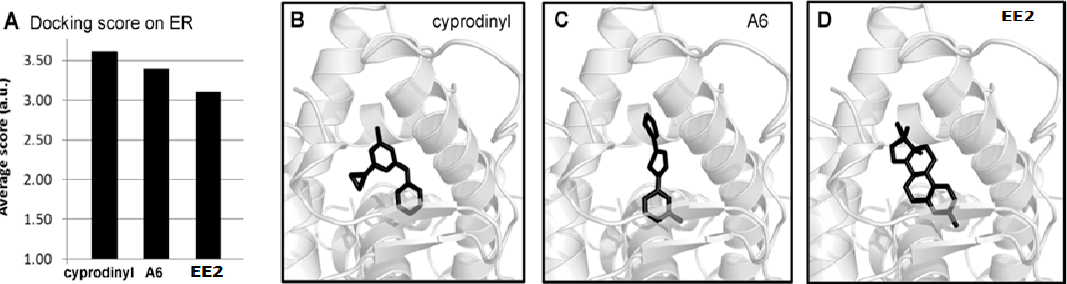
Figure 8. Putative binding of A6 and cyprodinyl to the ligand binding site of estrogen receptors (ER) predicted by the Genetic Optimization for Ligand Docking (GOLD) docking software. ( A ) Estimated binding efficiencies of cyprodinyl, A6, and the natural ligand analog 17- α -ethinylestradiol (EE2) for the ligand binding site of the ER (Protein Data Bank ID, 4MGA); ( B – D ) Graphical representation of cyprodinyl, A6, and EE2 docked on the ER ligand binding domain (Protein Data bank ID, 4MGA). Ligands are shown in black, the ligand binding domain in grey. All models were rendered in PyMOL.